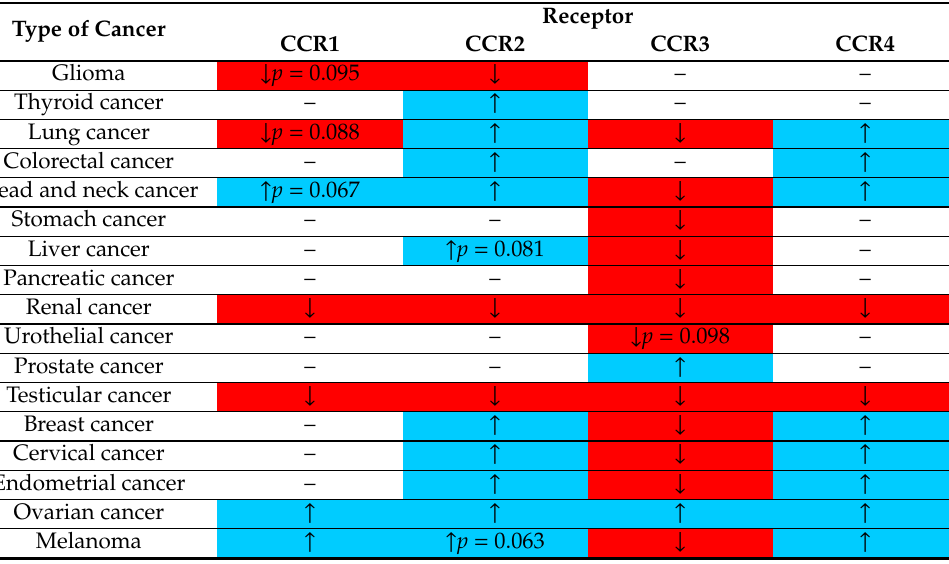
Table 3. CC chemokines discussed in this part of the article, including cells recruited to the tumor niche. Name Receptor